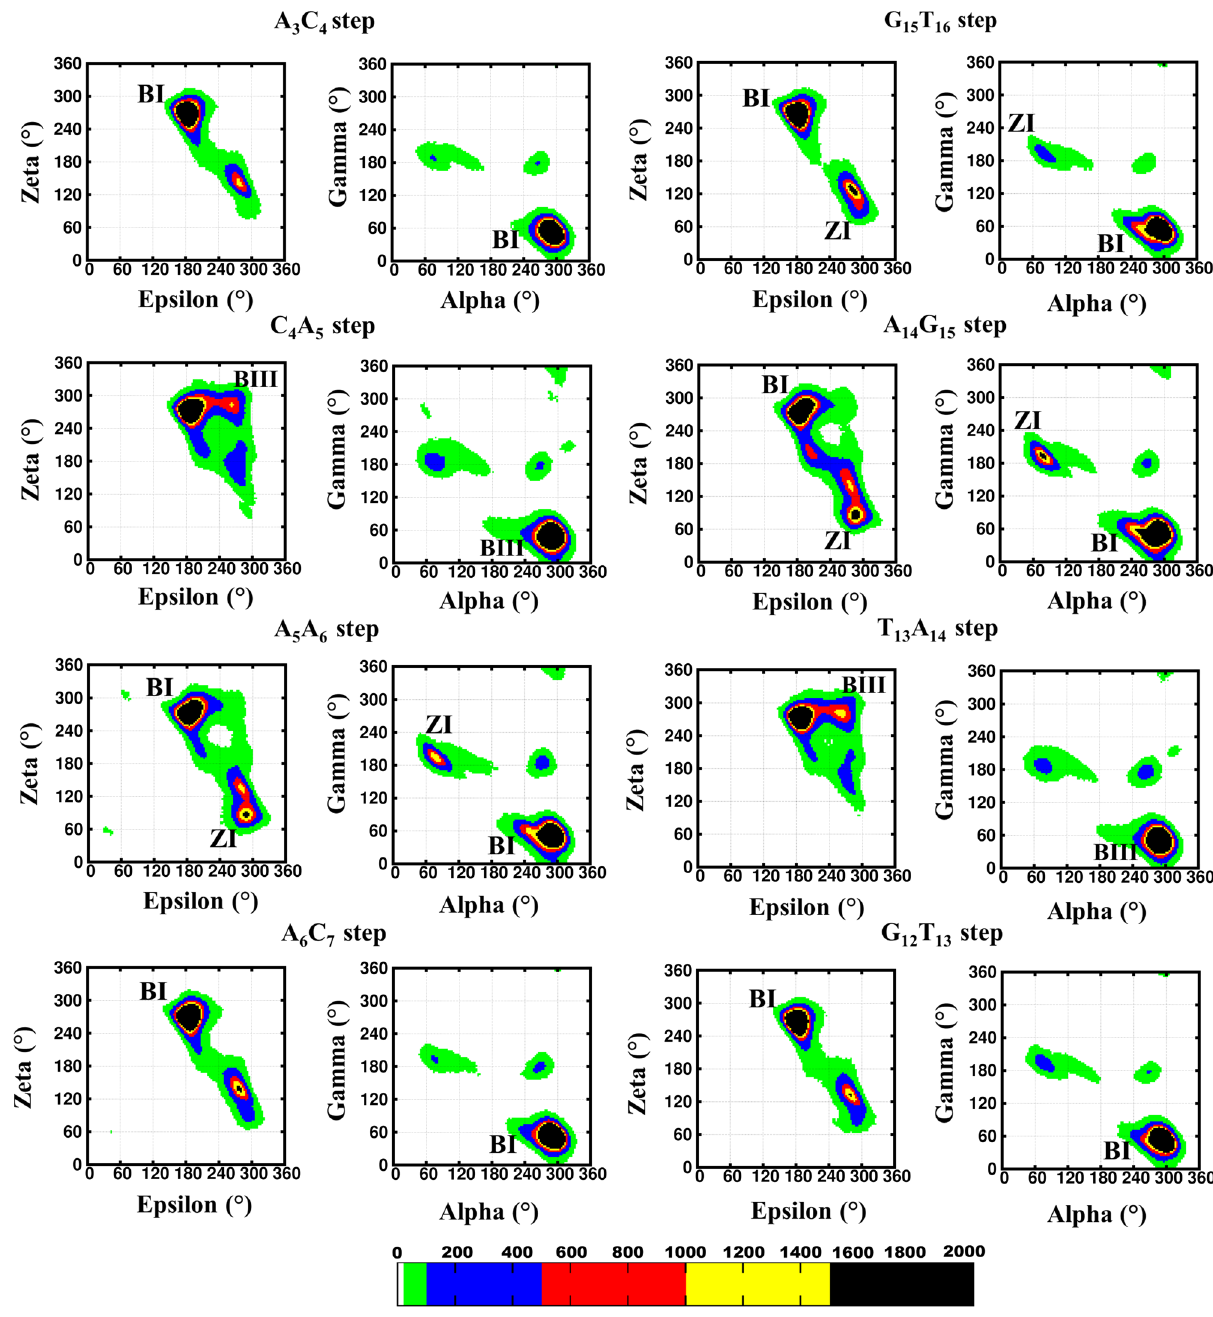
Figure 9. Backbone conformational preference (ε, ζ, α, γ) corresponding to the umbrella sampling simulation (Scheme DCA-1a). (ε&ζ) (1st and 3rd column) and (α&γ) (2nd and 4th column) 2D contour density plots corresponding to various steps in the vicinity of the mismatch. Note that the BI ((ε, ζ, α, γ) = (t, g − , g − , g + )), BII (g − , t, g − , g + ), BIII (g − , g − , g − , g + ) and ZI (g − , g + , g + , t) conformations are indicated adjacent to the corresponding regions. Other conformational intermediates can also be seen in the plot. The data corresponding to the last 2.5 ns simulation of the energetically favored regions (boxed in Fig. 6) is considered for the plotting. The scale corresponding to the isolines is given at the bottom. The GNUPLOT 5.2 software was used to plot the data 54